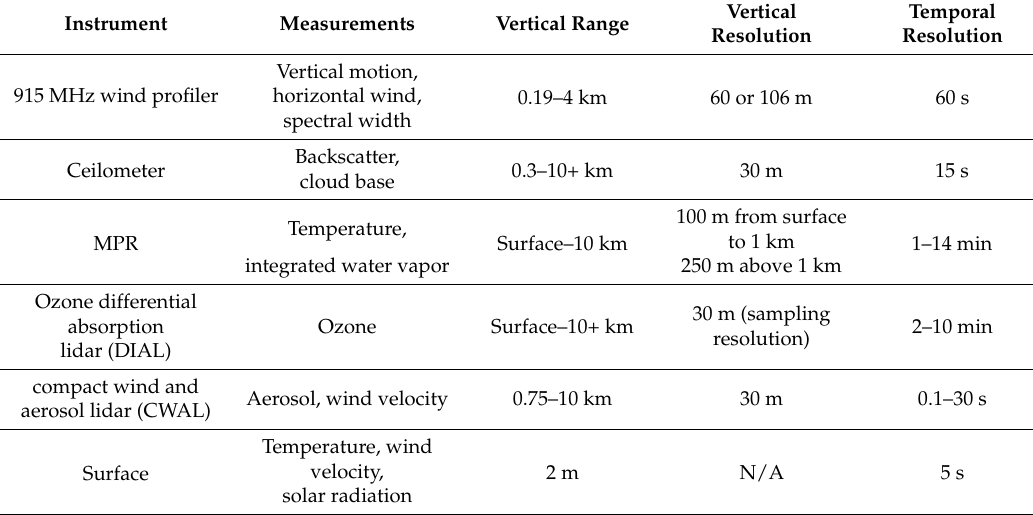
Table 1. Instrument